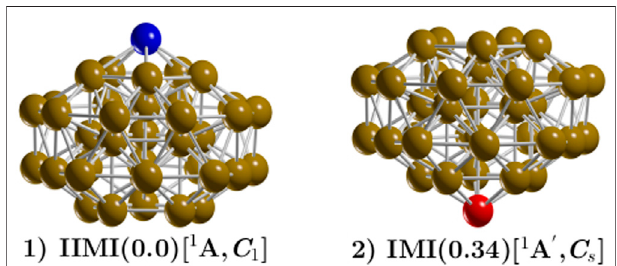
FIGURE 3 | (Color online) The inverted incomplete-Mackay icosahedron (IIMI) is labeled 1 and has C 1 symmetry. The incomplete-Mackay icosahedron (IMI)islabeled2,withsymmetryC s ,andislocated0.34 kcal/molenergyabove the putative minimum global at 298.15 K. The yellow, red, and blue colored spheres represent copper atoms. The IIMI structure is the result of interchanging the red Cu atom depicted in the IMI structure to the position of the blue atom in the IIMI structure. The IMI structure has been reported in reference Ref Zhang et al. (2019). as the low-energy structure. The Highest Occupied Molecular Orbital (HOMO) — Lowest Unoccupied Molecular Orbital (LUMO) gapoftheIMIstructureis0.24 eV (0.356 eV reportedin previousDFT studies (Zhang et al., 2019). In contrast, the HOMO-LUMO gap for the IIMI structure is 0.30 eV. This, provides a plausible explanation for the higher energetic stability of why the IIMI structure is energetically more stable.